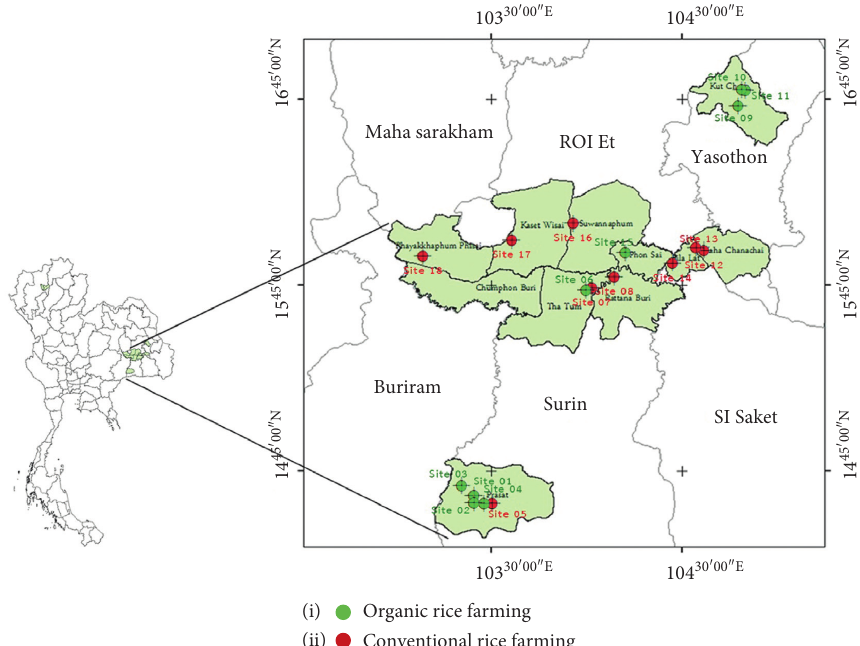
Figure 1: Eighteen sampling sites in the Tung Kula Rong Hai region and neighbouring areas of Surin and Yasothon